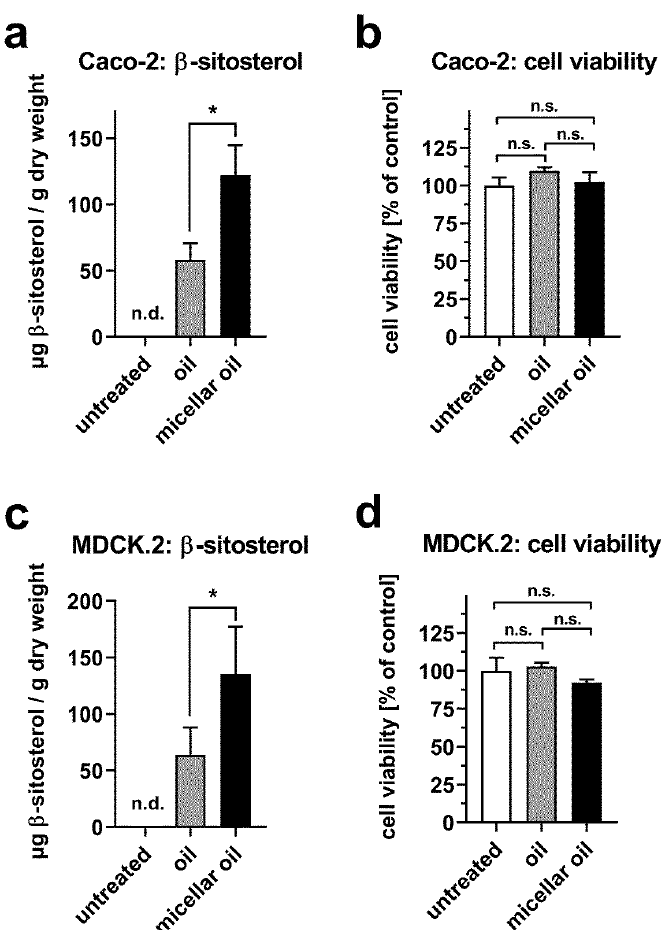
Figure 5. Uptake of phytosterols from phytogenic oil. Di ff erentiated Caco-2 cells ( a ) or MDCK.2 cells ( c ) were incubated with native or micellar oils at a final concentration of 0.75% for 6 h. Cellular β -sitosterol content was quantified by HPLC-MS and normalized to cell dry mass. Cell viability of Caco-2 ( b ) or MDCK.2 cells ( d ) was assessed after incubation with 0.75% oil or micellar oil for 24 h. Data were pooled from two independent experiments performed in duplicate. Bars represent mean ± SD. * p <